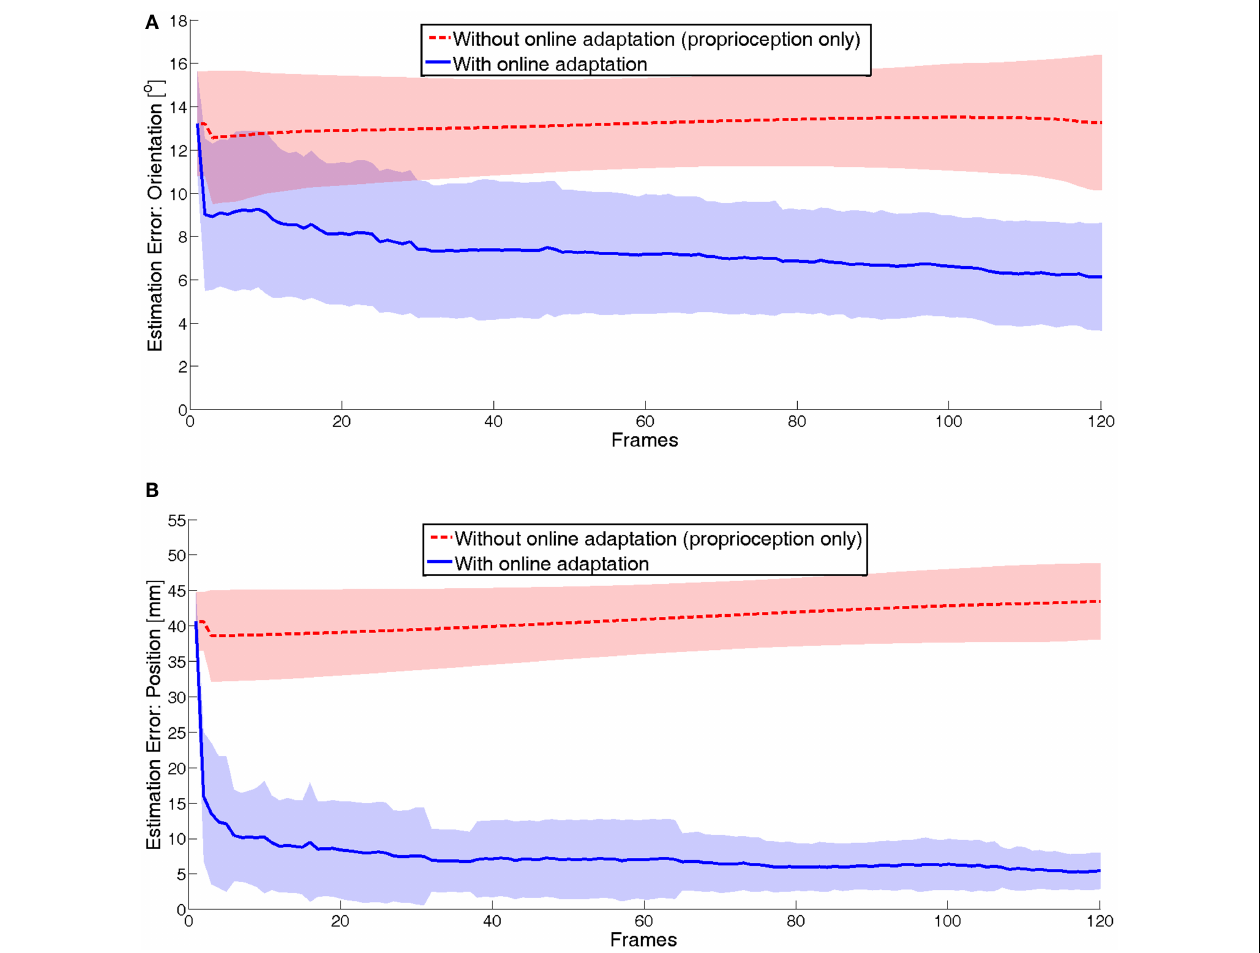
FIGURE 6 | Estimation error of the end-effector during the open-loop phase: (A) orientation and (B) position